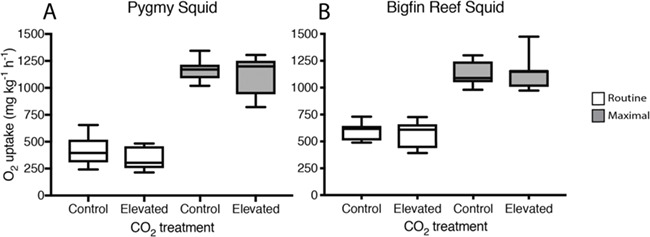
Routine (white boxes) and maximal oxygen uptake (grey boxes) of pygmy squid (A) and bigfin reef squid (B) from current day control and elevated CO2 treatments; boxplots show the median and interquartile range and the minimum and maximum range of the data.